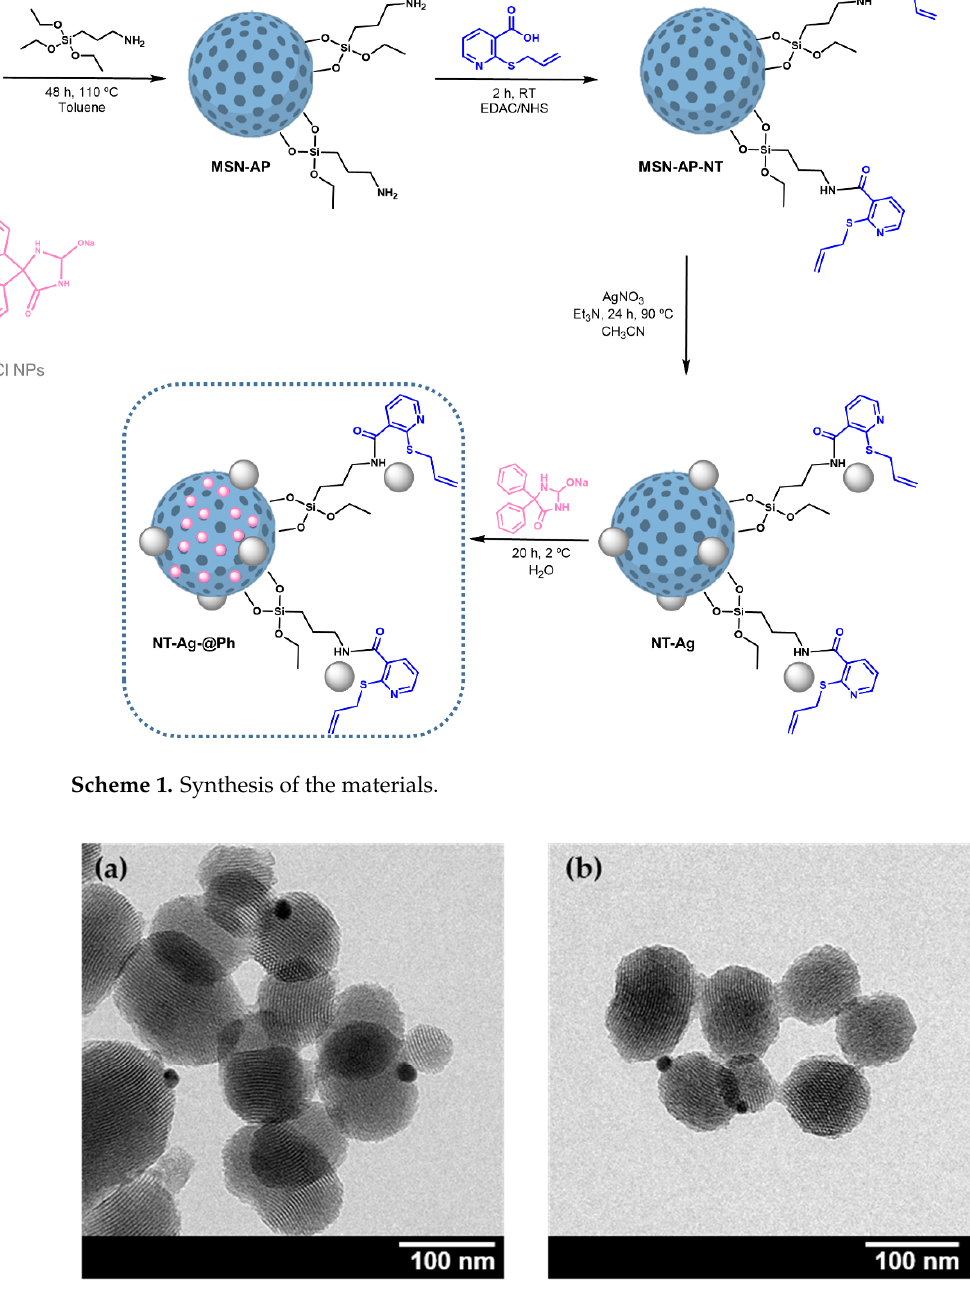
Table 1. Textural parameters of selected MSN materials obtained from nitrogen adsorption–desorp- tion analysis.